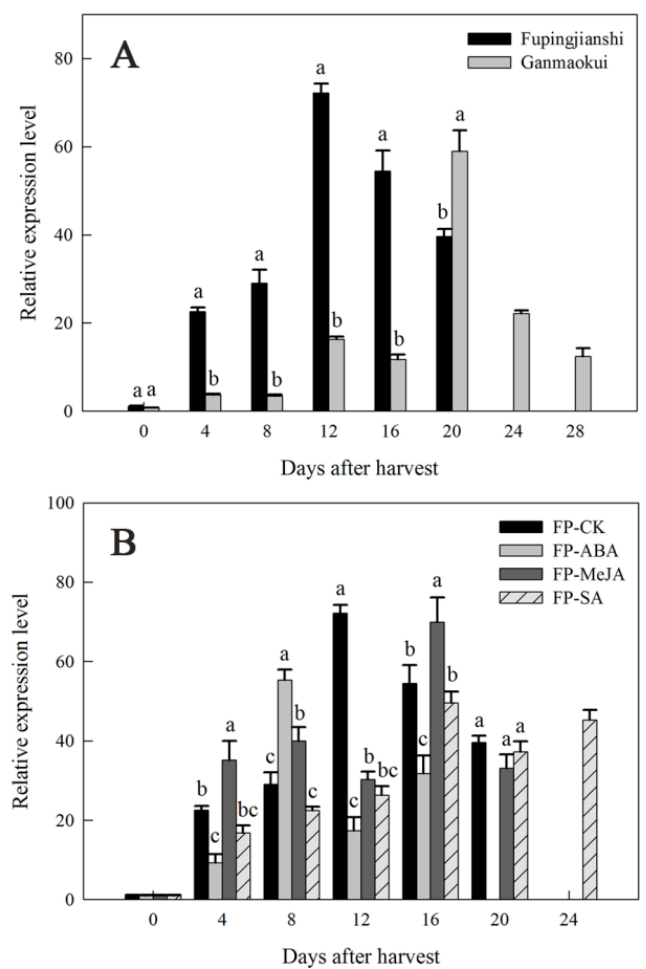
Figure 5. Expression pattern of DkLOX3 in persimmon fruits during storage. ( A ) Expression pattern of DkLOX3 in two persimmon cultivars; ( B ) expression pattern of DkLOX3 in hormone-treated “Fupingjianshi” fruits. FP-ABA, FP-MeJA and FP-SA indicated “Fupingjianshi” fruits treated with ABA (189 µM, 2 min), MeJA (100 µM, 10 min) and SA (100 µM, 10 min), respectively, and stored at 20 ± 1 °C. The fruits were immersed in water and stored at 20 ± 1 °C, served as the FP-CK. The values for each time point represent the average from three PCR runs for three biological replicates. Vertical bars represent standard errors of means. Columns with different letters at each time point indicate significant differences according to the LSD test ( p < 0.05).